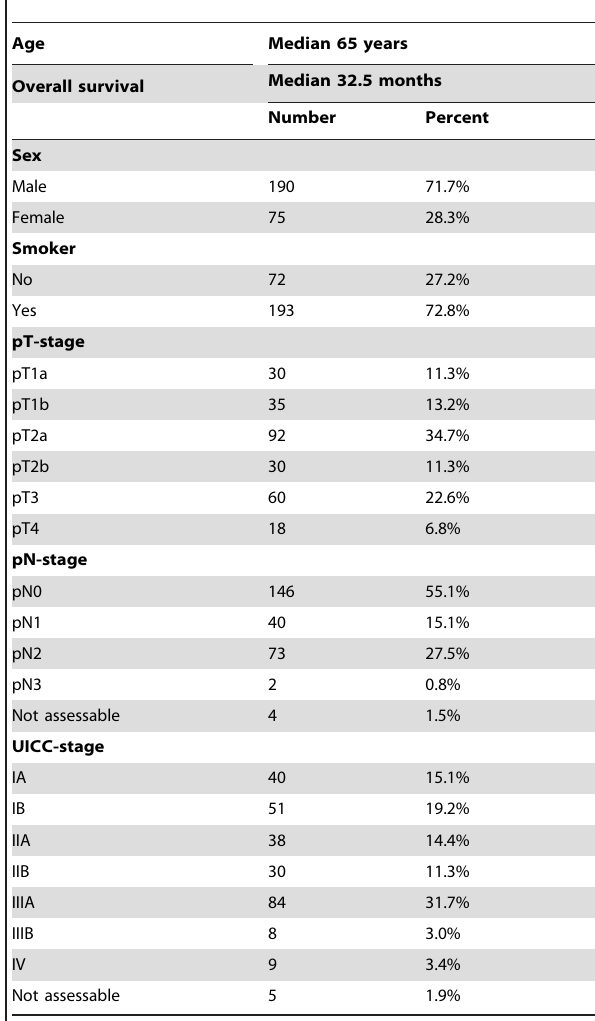
Table 1. Summary of clinico-pathological data of included NSCLC